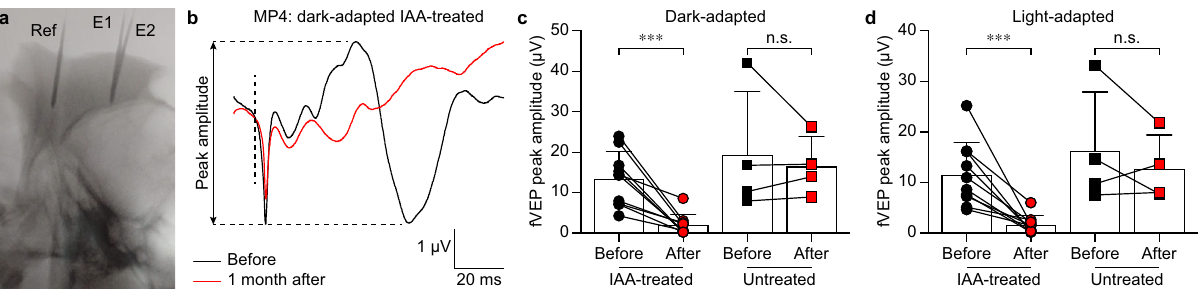
Fig. 3 fVEPs in blind minipigs. a Sagittal radiographic image of one minipig implanted with three electrodes for the recordings of fVEPs. Ref: reference electrode; E1: recording electrode 1; E2: recording electrode 2. b Dark-adapted fVEPs at 30 cd s m − 2 in an IAA-treated minipig before and 1 month after IAA administration. The vertical dashed line indicates the onset of the fl ash. The quanti fi cation of the peak amplitude is indicated. Data were from MP4 (IAA- treated). c Quanti fi cation of the dark-adapted fVEPs at 30 cd s m − 2 in IAA-treated minipigs (mean ± s.d.; n = 10 eyes from N = 5 minipigs) before and 1 month after IAA administration and in untreated minipigs (mean ± s.d.; n = 4 eyes from N = 2 minipigs) at matching time points. Two-tailed paired t -test; IAA-treated: p = 0.0005 (***) and power 1.00; untreated: p = 0.5835 (n.s.) and power 0.70. d Quanti fi cation of the light-adapted fVEPs at 30 cd s m − 2 in IAA-treated minipigs (mean ± s.d.; n = 10 eyes from N = 5 animals) before and 1 month after IAA administration and in untreated minipigs (mean ± s.d.; n = 4 eyes from N = 2 minipigs) at matching time points. Two-tailed paired t -test; IAA-treated: p = 0.0008 (***) and power 0.99; untreated: p =